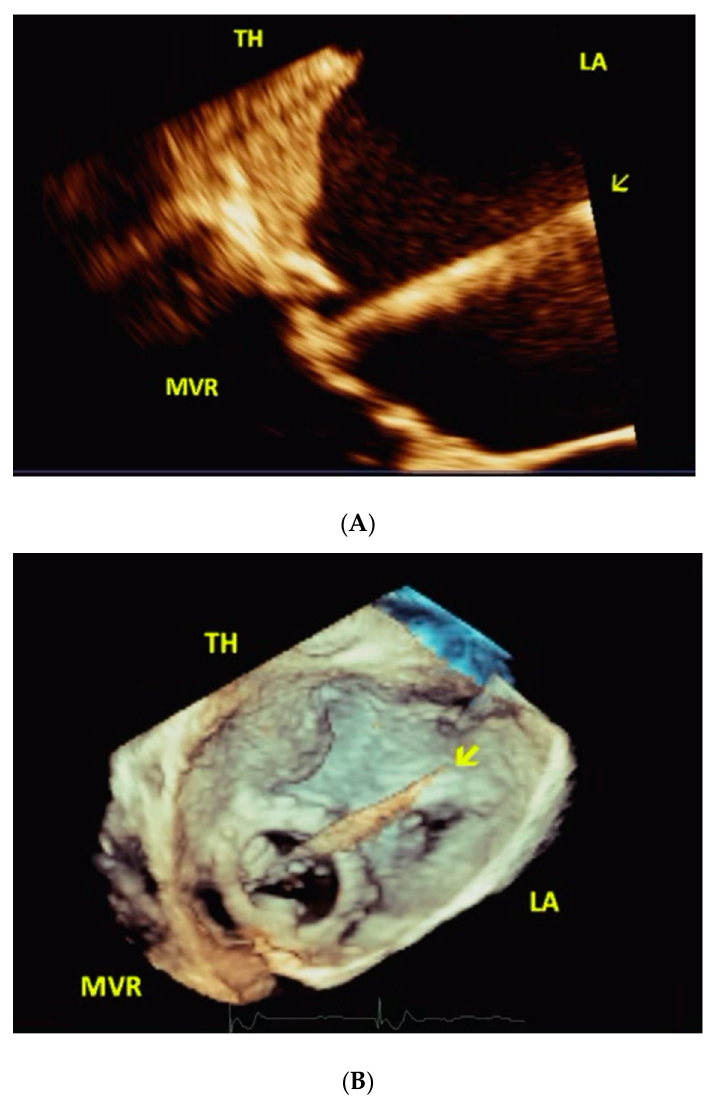
Figure 4. ( A , B ). 67-year-old male with severe MVR stenosis (Case 4). During procedure. Live/real- time three-dimensional transesophageal echocardiography ( A , B ). The arrow points to the catheter deployment device passing through MVR and bypassing the TH in MPR mode in A and in full volume mode in B Abbreviations as in previous Figures.